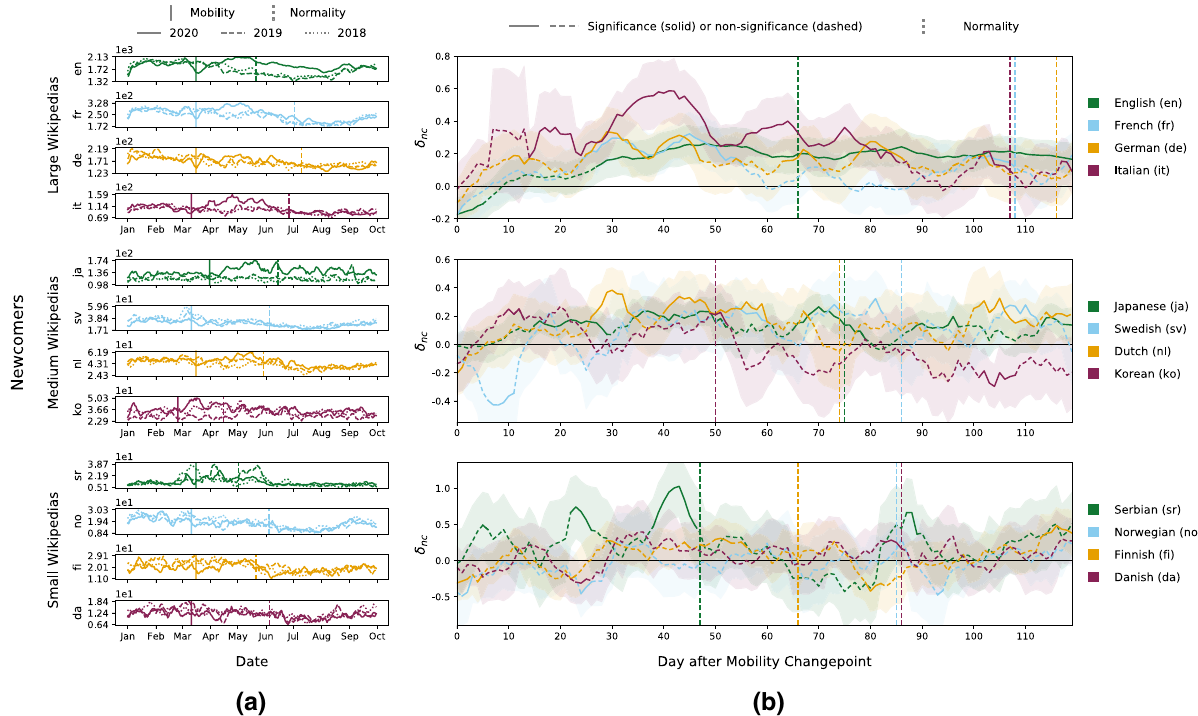
Figure 3. Newcomers during COVID-19 mobility restrictions. We visualize newcomer results in large (top), medium (middle), and small (bottom) Wikipedias during COVID-19 mobility restrictions, which we delineate via mobility (when restrictions become effective) and normality (when restrictions are lifted) changepoints. ( a ) We depict rolling 7-day average newcomer counts until October of 2018, 2019, and 2020. For many Wikipedias, newcomer acquirement strongly declines right around their mobility changepoint, but then quickly rises to or even exceeds pre-pandemic baselines. ( b ) We investigate the relative change in newcomers ( nc ) via δ nc as computed from DiD analysis (95% confidence intervals as two standard deviations) and plot δ nc for 120 left- aligned 7-day windows (see “Methods”), starting with the respective mobility changepoint. In large Wikipedias, considerably more newcomers join in the weeks after mobility restrictions come into effect, relative to before the changepoint and previous years. Results for medium and small Wikipedias are non-conclusive, with some showing increases in the number of newly acquired editors and others not significantly changing their